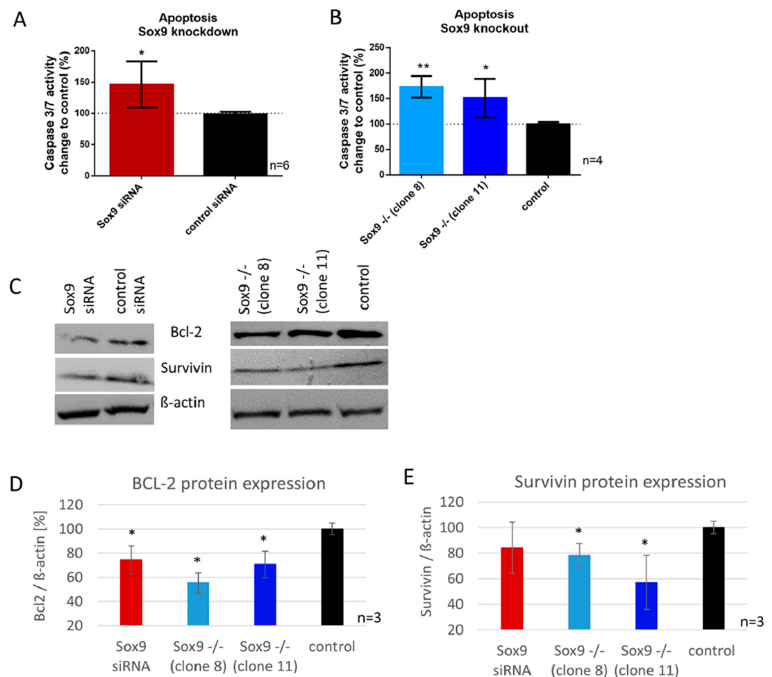
Figure 3. Effect of SOX9 knockdown and knockout on apoptosis. ( A , B ) Increased apoptosis in SOX9 knockdown and knockout cells was measured via Caspase 3/7 activity assay. ( C ) Western blot analysis of BCL-2 and survivin after SOX9 knockdown and knockout revealed a decrease in both anti-apoptotic proteins. ( D , E ) Densitometric analysis of 3 independent Western blots are shown. * p ≤ 0.05, ** p ≤ 0.01.